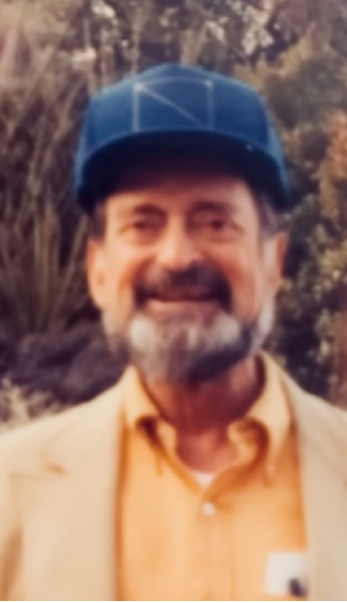
Figure 3: Frank Harary, New Mexico State University